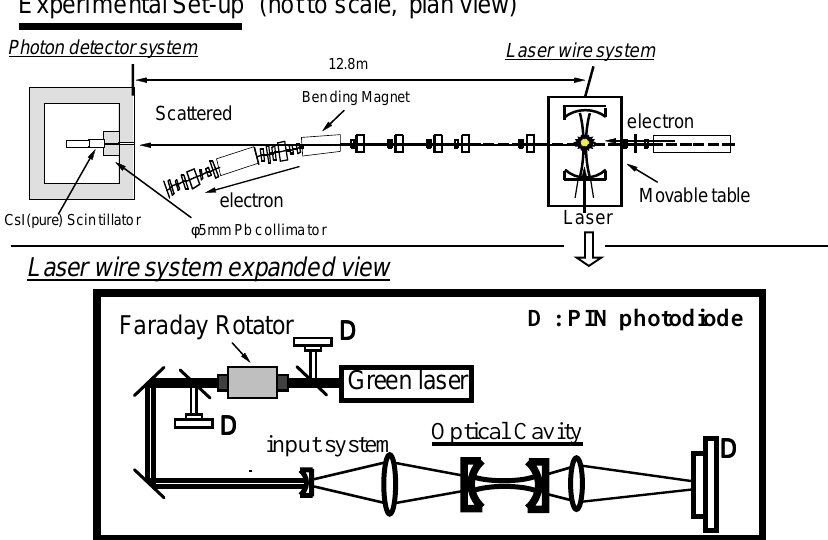
FIG. 1. Schematic diagram of the experimental setup. The lower part is an expanded view of the laser wire system.